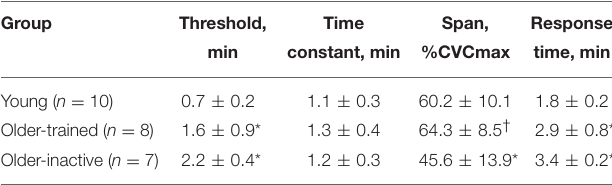
Values represent Mean ± 1 SD. CVC, cutaneous vascular conductance expressed as a percent of maximal (%CVCmax); min, minute, Time Constant, the time required to reach 63.2% of the Span, Span, difference in CVC from baseline to 5min, Response time, time from start of heating till CVC reaches 63.2% of the Span and Response time, equals the time constant + threshold. * p < 0.05 different from young. † p < 0.05 different from older- inactive. The data for the young group were previously reported (Mack et al.,